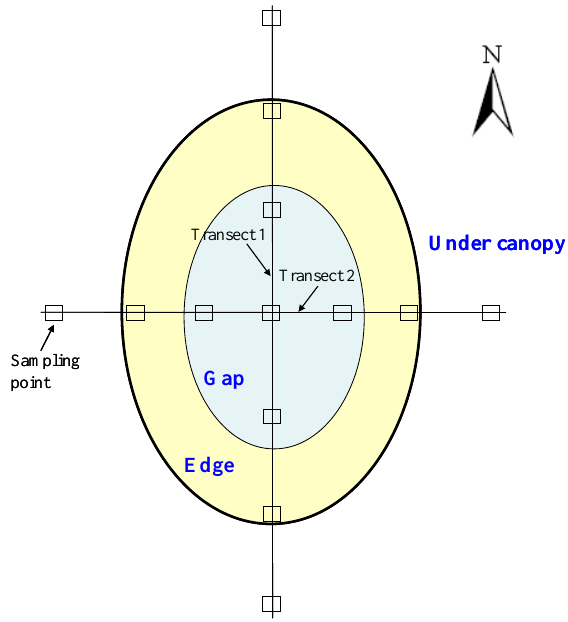
Figure 1. Transects and sampling points used to investigate the seed rain and soil seed banks, and three categories of positions (i.e., gap, edge, and under canopy) determined according to the distances from the center of each artificial forest gap.